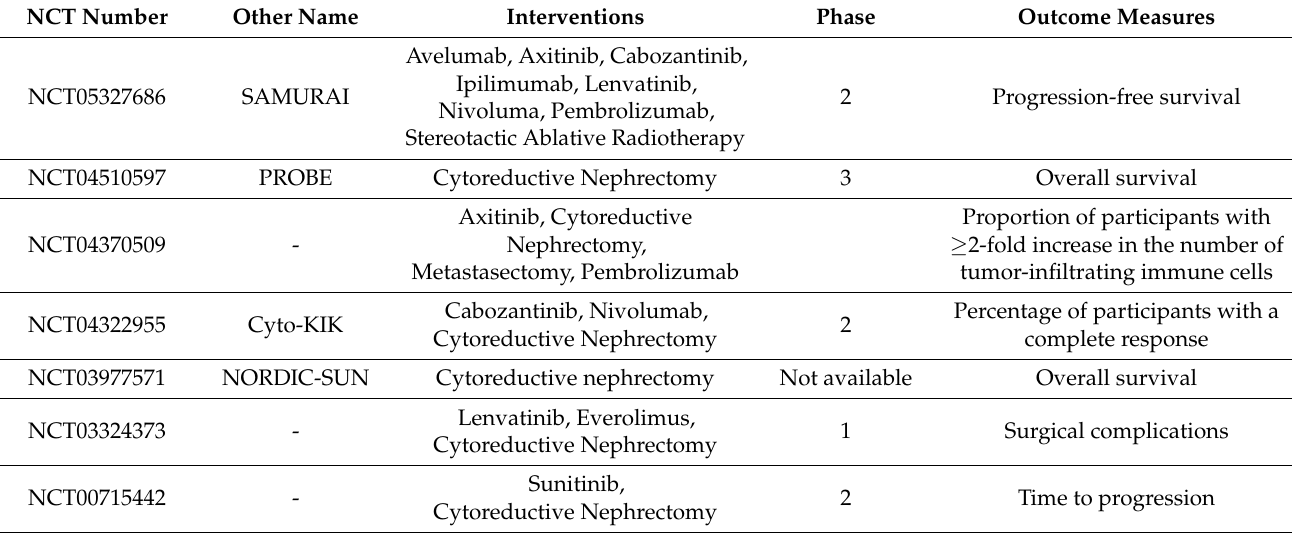
Table 2. Current ongoing trials involving cytoreductive